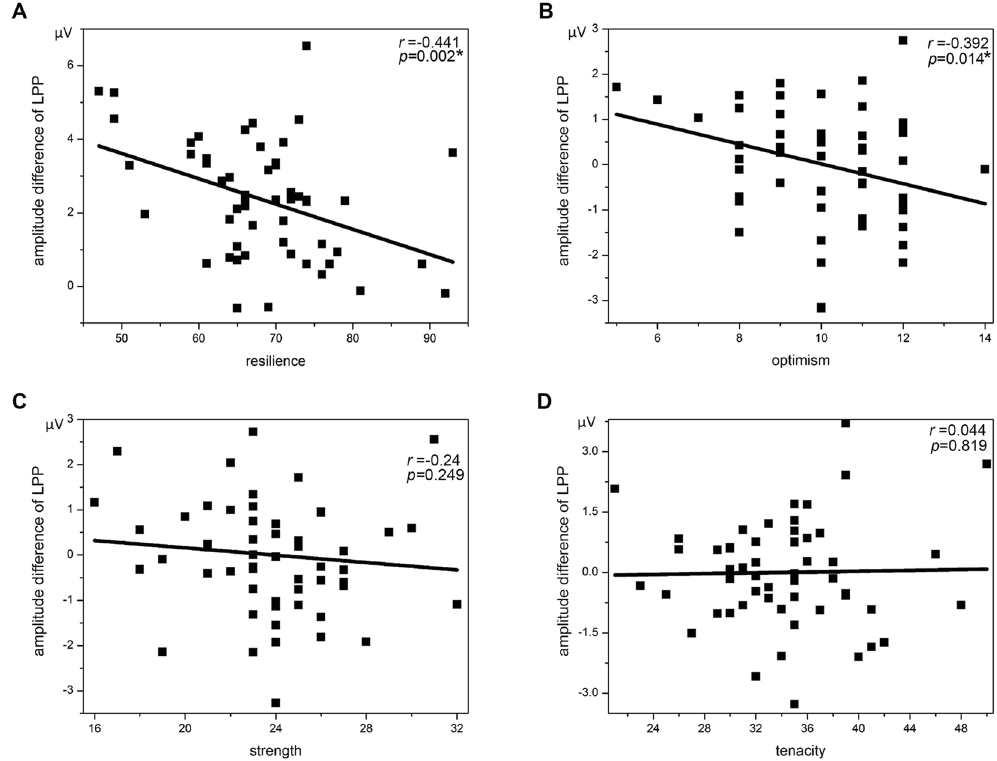
Figure 2. Linear association between the amplitude difference of LPP and different predictive variables of resilience ( A ), optimism ( B ), strength ( C ) and tenacity ( D